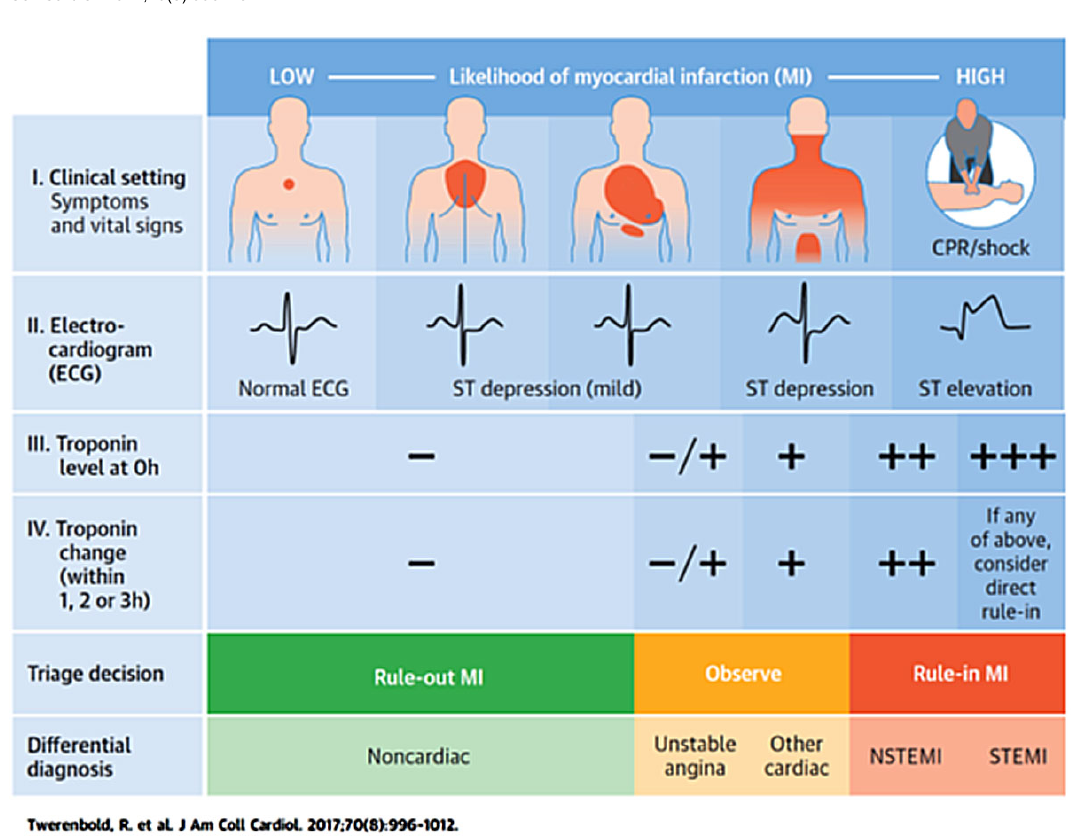
Figure 1: Clinical assessment of patients presenting with suspected acute coronary syndrome. The initial assessment is based on the integration of low likelihood and/or high likelihood features derived from clinical setting (symptoms, vital signs), 12-lead ECG, and cardiac